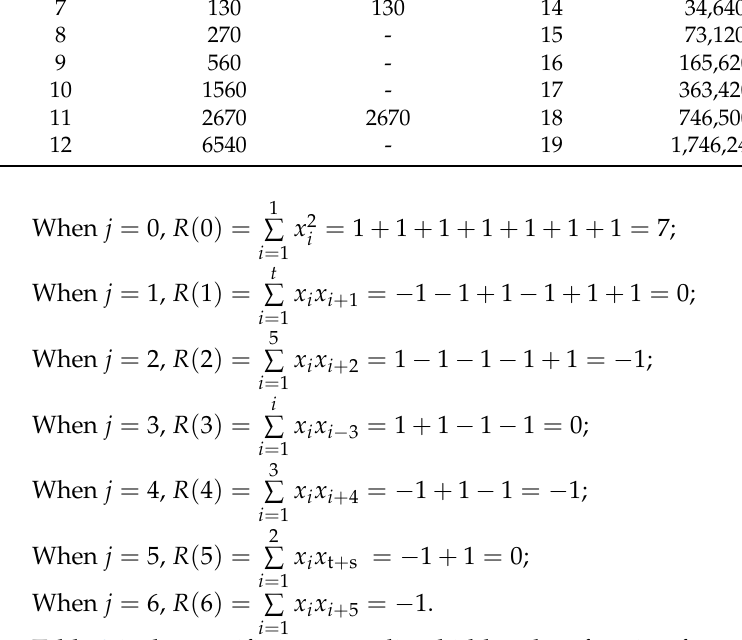
Table 2 is the specific image coding hidden data framing format, in which the first frame data only includes the system parameters and the number of sampling